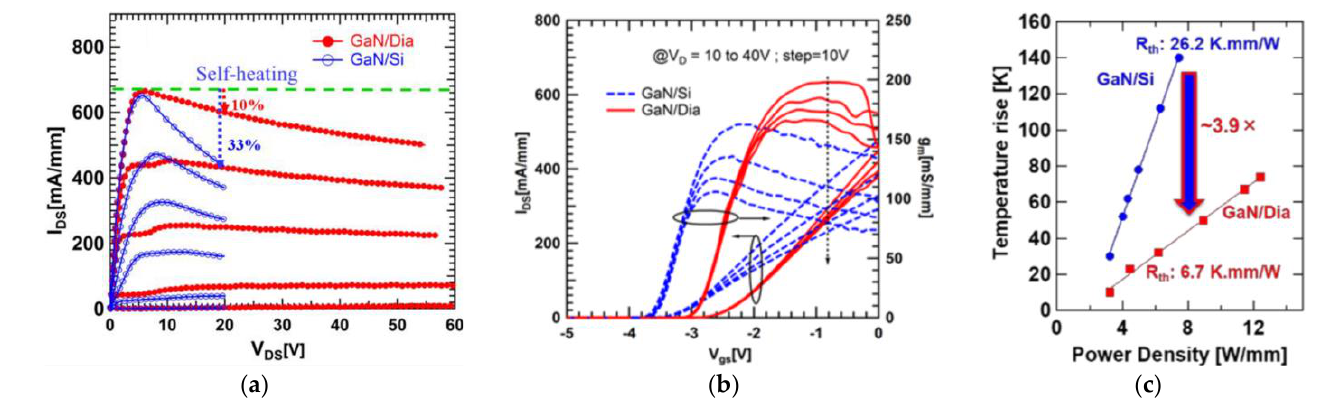
Figure 4. ( a ) I D versus V D characteristics, ( b ) Transfer characteristics for different V D , and ( c ) Tem- perature rise versus P D for similar GaN-on-diamond and GaN-on-Si HEMTs (reprinted from [28]; permission conveyed through CCBY 4.0: https://creativecommons.org/licenses/by/4.0/~ (accessed on 7 October 2021)).